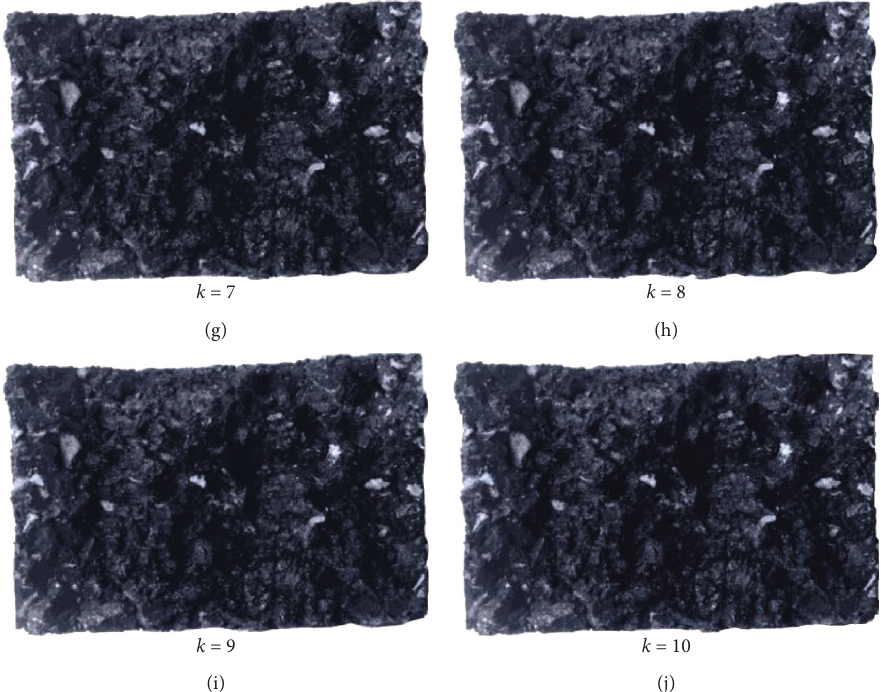
Figure 13: Clustered images of WP170 subjected to 3FTsample specimen. (a) Original. (b) k � 2. (c) k � 3. (d) k � 4. (e) k � 5. (f) k � 6. (g) k � 7. (h) k � 8. (i) k � 9. (j) k �